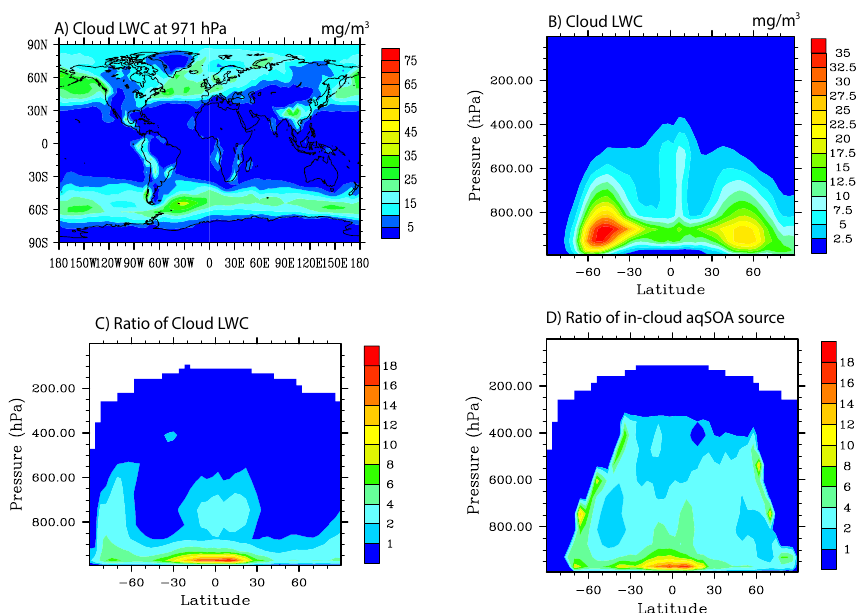
Figure 4. Annual mean grid-box averaged cloud liquid water content (LWC) in mg/m 3 from the GFDL AM3 cloud field at approximately 971hPa (A) and zonal mean content (B) for Case 4. Panel C shows the zonal mean distributions for the ratio of grid-box averaged cloud LWC in Case 1 to that in Case 4; panel D shows the zonal mean distributions for the ratio of the source of aqSOA formed in cloud water in Case 1 to that in Case 4.